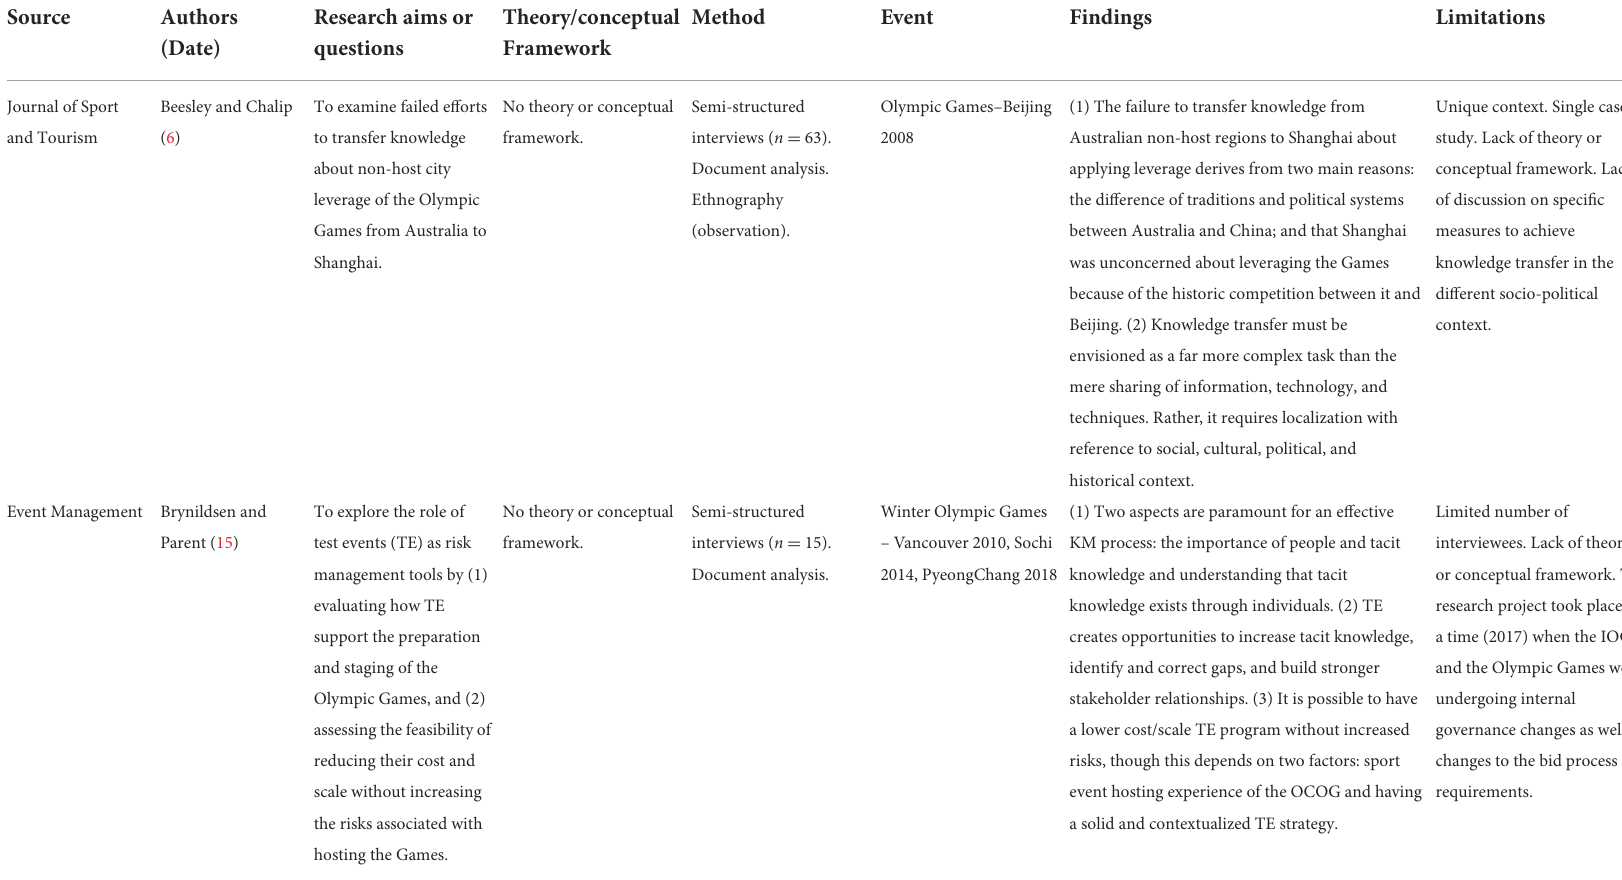
TABLE 2 Summary of extracted data from studies included in the systematic